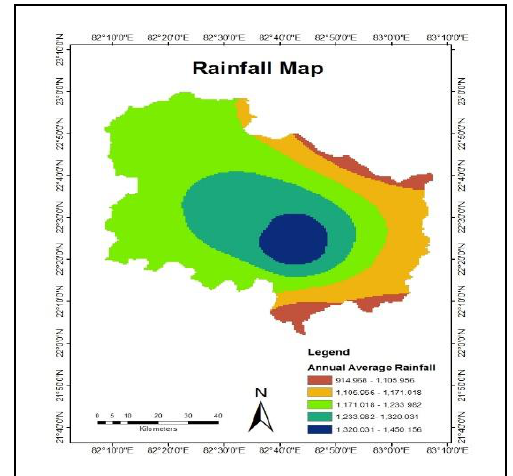
Figure 5. Annual average rainfall map